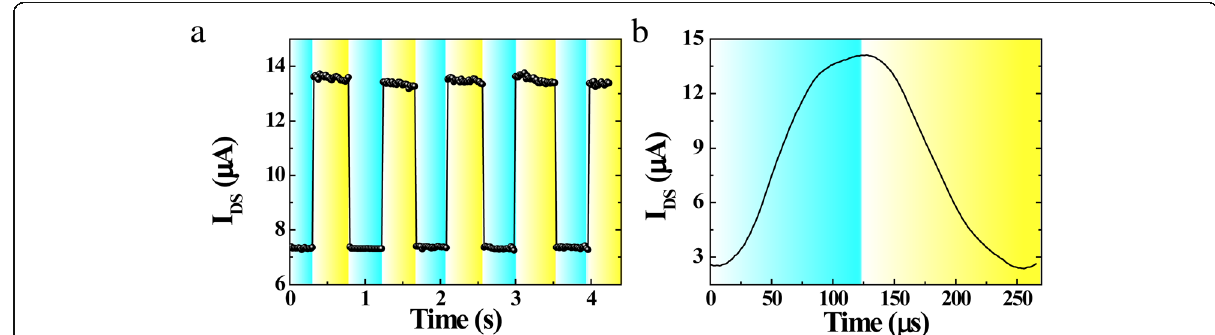
Fig. 4 Photoresponse characteristics of CCPD. a Current response of the devices under irradiation ( λ = 405 nm) at V DS = 1 V and V GS = 1 V. b Temporal photocurrent response of the CCPD under irradiation of 648 mW/cm